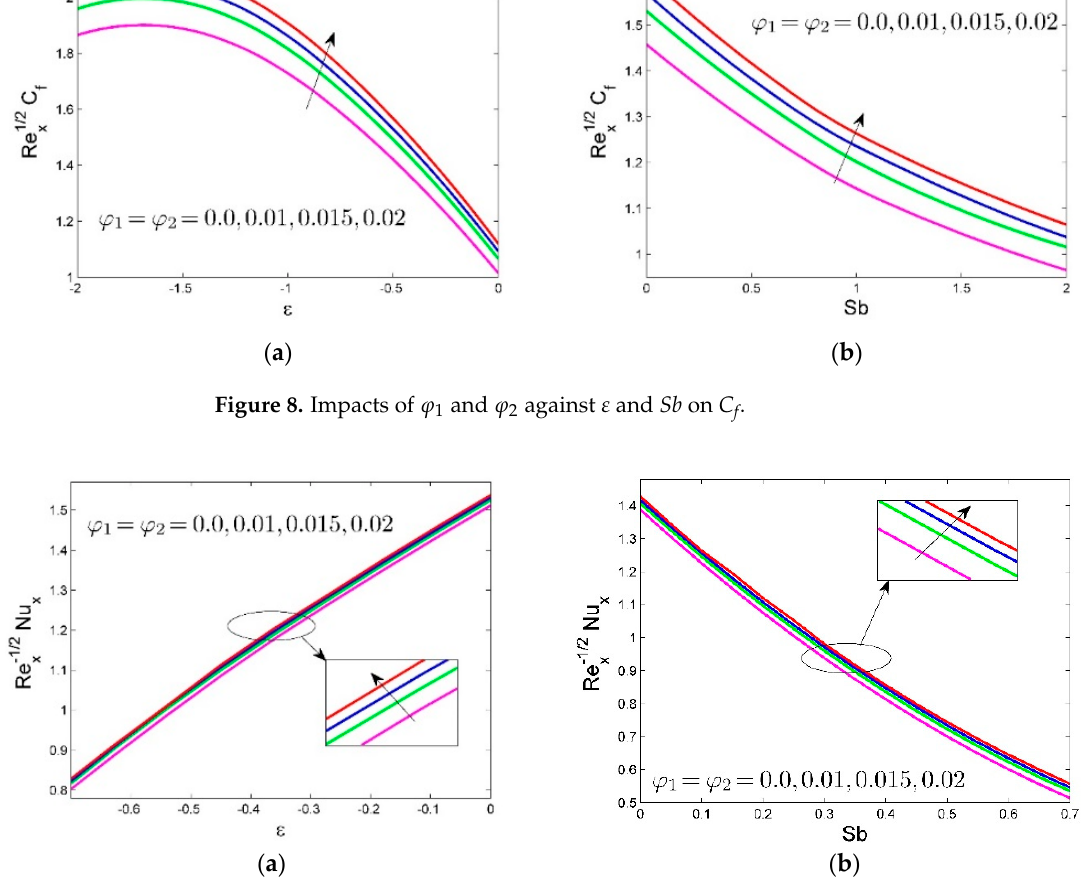
Figure 9. Impacts of ϕ 1 and ϕ 2 against ε and Sb on Nu .